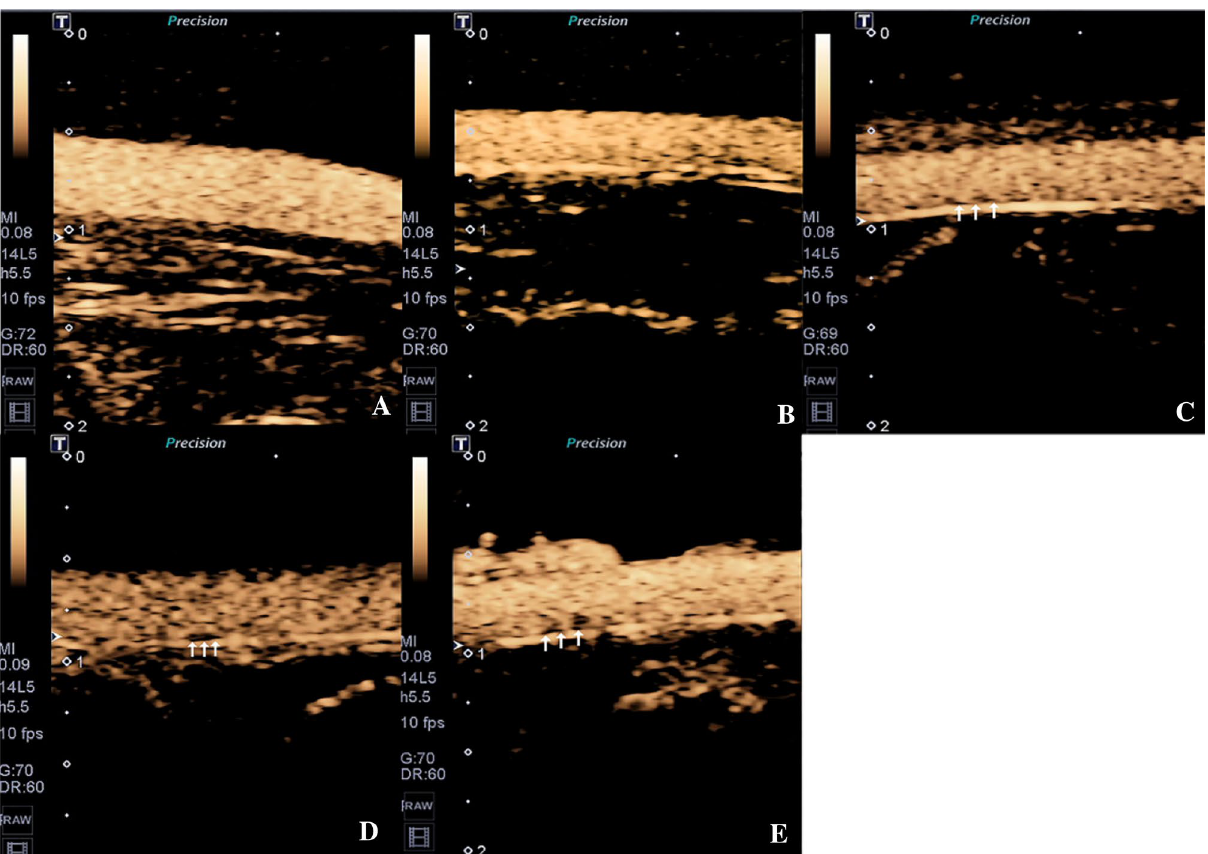
Figure 3. SonoVue ultrasonic contrast images of abdominal aorta of rabbits in different groups, five rabbits in each group. ( A ) Control group; ( B ) Week-4 group; ( C ) Week-8 group; ( D ) Week-12 group; ( E ) Week-16 group. The plaque on the wall was indicated by the